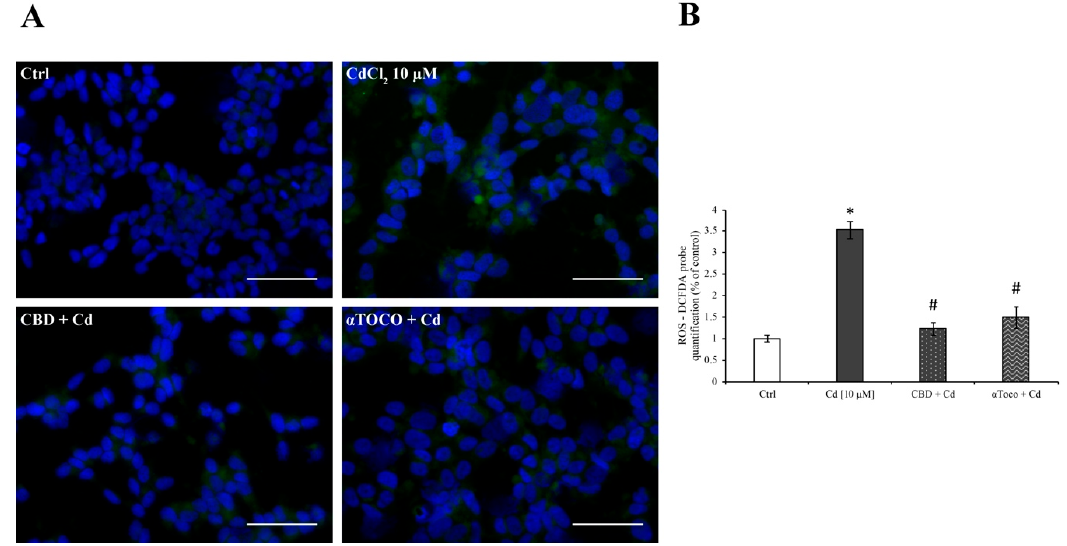
Figure 2. Immunofluorescence staining and ROS production quantification. ROS expression was quantified by the 2’,7’- dichlorodihydrofluorescein diacetate (CM-H 2 DCFDA) probe. ( A) Representative fluorescent images of intracellular ROS levels after CdCl 2 10 μ M treatment, with or without CBD or α Toco pre-treatment. ( B) Fluorescence semi-quantitative analysis highlighting the role of Cd (dark column) in increasing ROS production and the role of CBD (dotted column) or α Toco (wavy column) in preventing ROS formation. The intracellular ROS-derived fluorescence is expressed as the percentage of fluorescence compared to control, untreated cells, taken as 100%. Results are expressed as mean ± S.E.M. Each experiment point was performed in triplicate, from three different set of experiments. Five different microscopic fields for each experimental point were analyzed. Total magnification: 400×. Scale bar: 50 μ m. * p < 0.05 vs. Ctrl; # p < 0.05 vs. Cd.